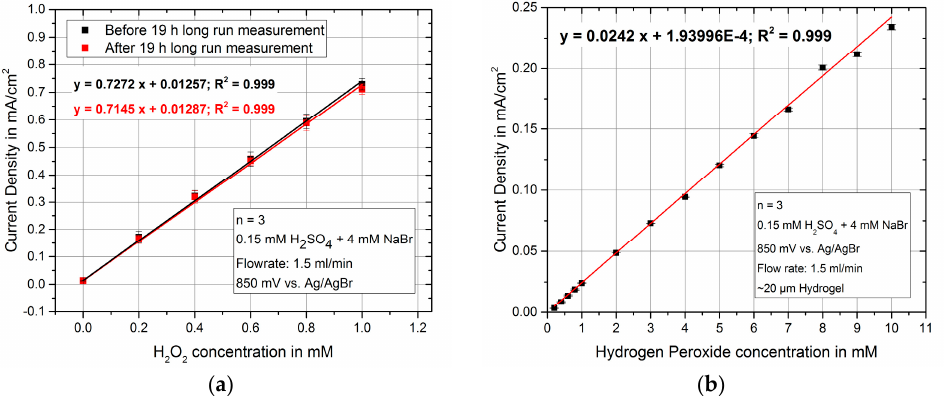
Figure 3. ( a ) Calibration curves for the detection of H 2 O 2 for concentrations up to 1 mM show excellent linearity (R 2 = 0.999) and high sensitivity (727 μ A cm − 2 mM − 1 ). Continuous long-term measurements showed no loss of sensitivity over a measurement time of 19 h; ( b ) Calibration curve for the amperometric detection of H 2 O 2 with 20 μ m pHEMA-based hydrogel applied to the electrode increasing the linear range